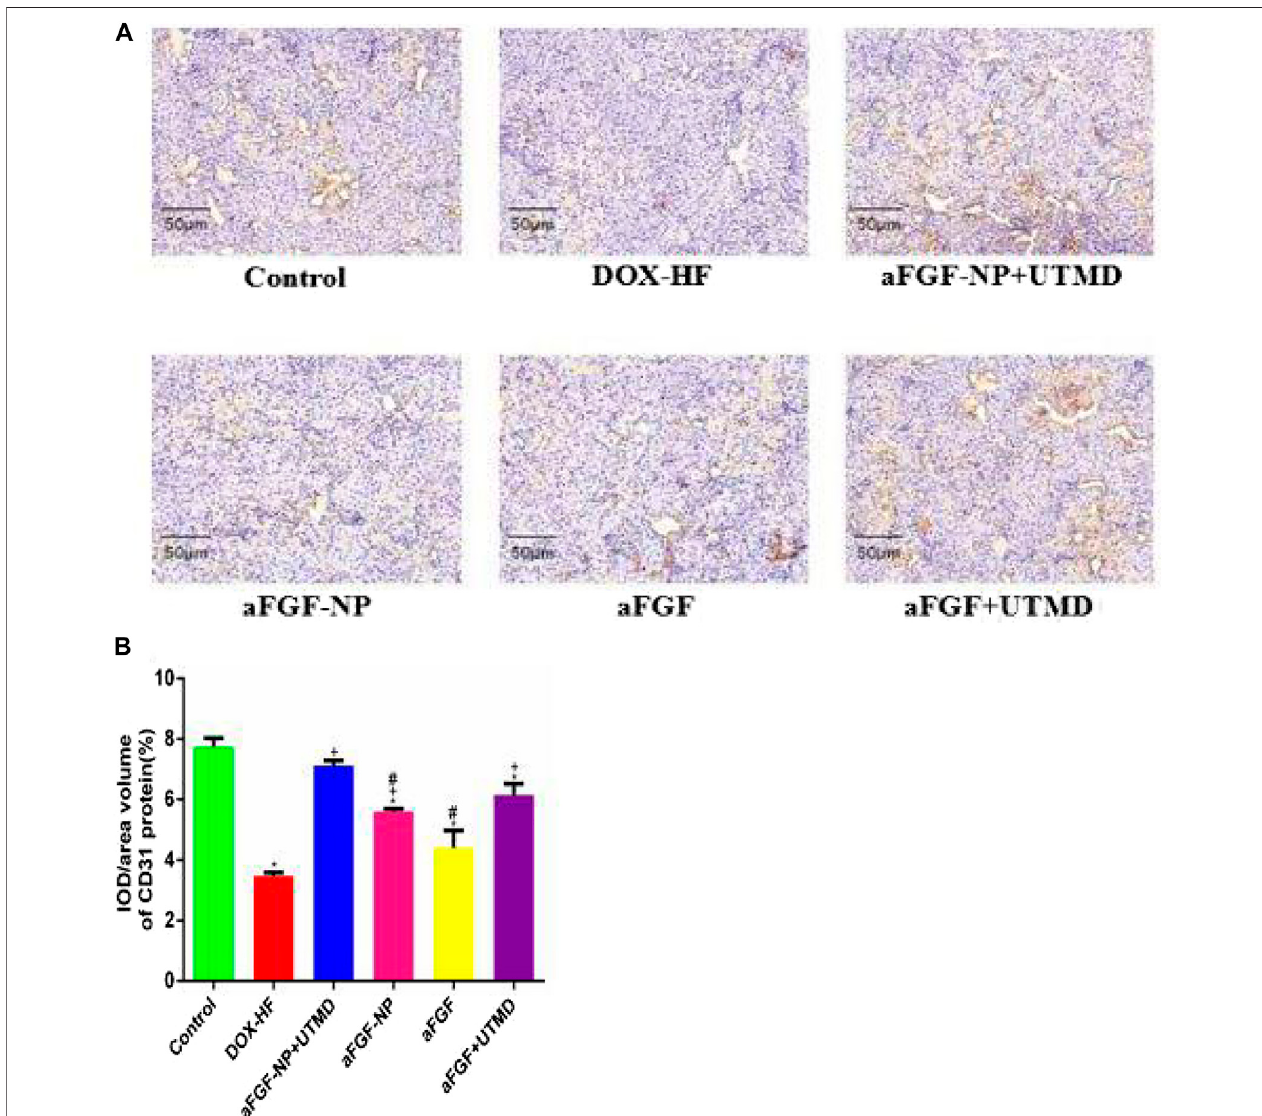
FIGURE 6 | The aFGF – NP + CPMBs combined with UTMD promoted angiogenesis of myocardial tissue in DOX – HF rats. (A) .: Representative photos of CD31 immunohistochemical staining in each group (400x); (B) : Quantitative analysis of positive expression of CD31. All data are expressed as mean ± SEM. * p < 0.05 vs. Control group; + p < 0.05 vs. DOX – HF group; # p < 0.05 vs. aFGF – NP + UTMD group. aFGF, acidic fi broblast growth factor; NP, nanoparticles; CPMBs, cationic lipid microbubbles; UTMD, ultrasound targeted microbubble destruction; DOX, doxorubicin; HF, heart